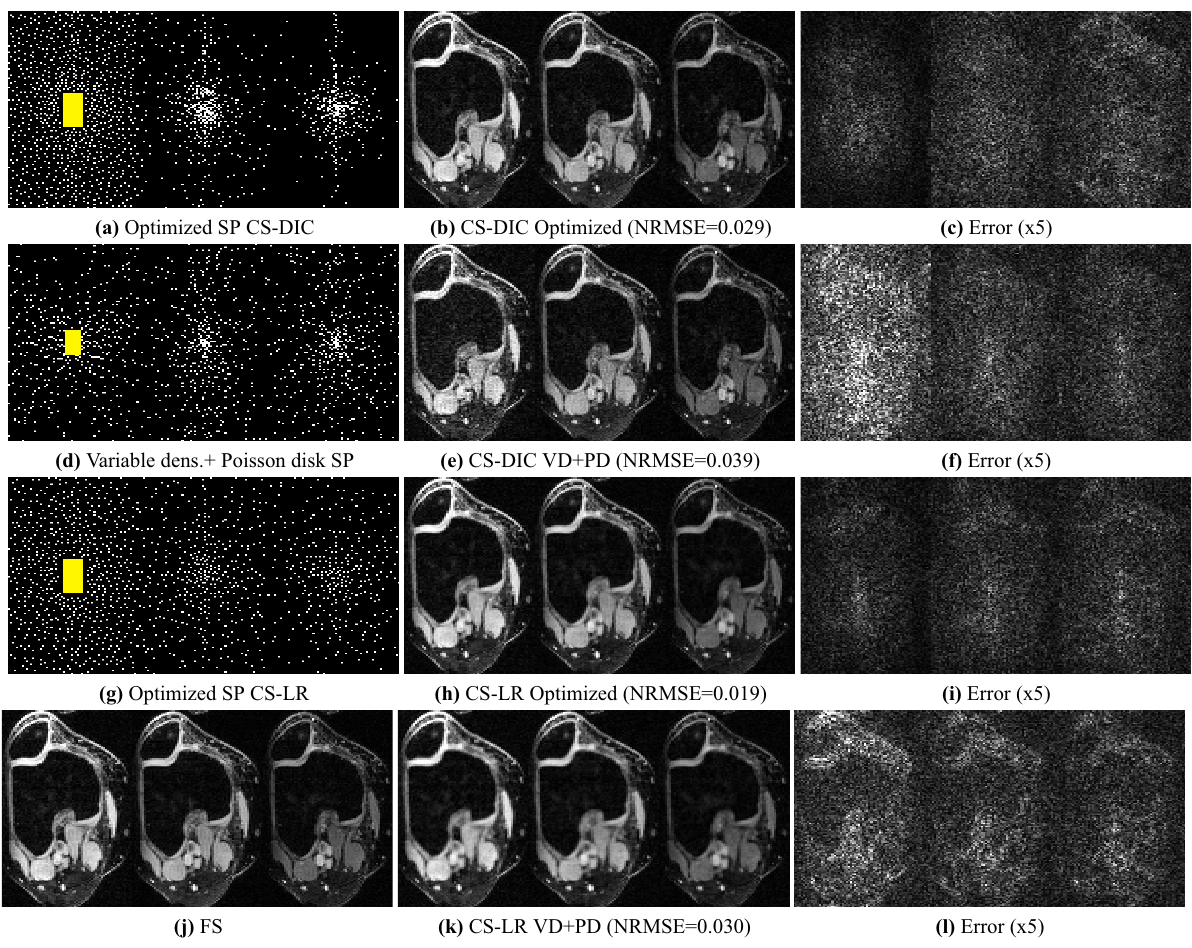
Figure 8. Three frames for different relaxation times of the knee dataset, when AF = 18 was used, reconstructed with CS-DIC ( b ) and ( e ) and with CS-LR ( h ) and ( k ): compare these with the corresponding fully sampled (FS) measurements in ( j ), where the corresponding magnitude of the errors are in ( c,f,i,l ). Combined variable density and Poisson disk SP ( d ) and BASS optimized SPs for CS-DIC ( a ) and CS-LR ( g ) are also shown. Central auto-calibration area is highlighted in